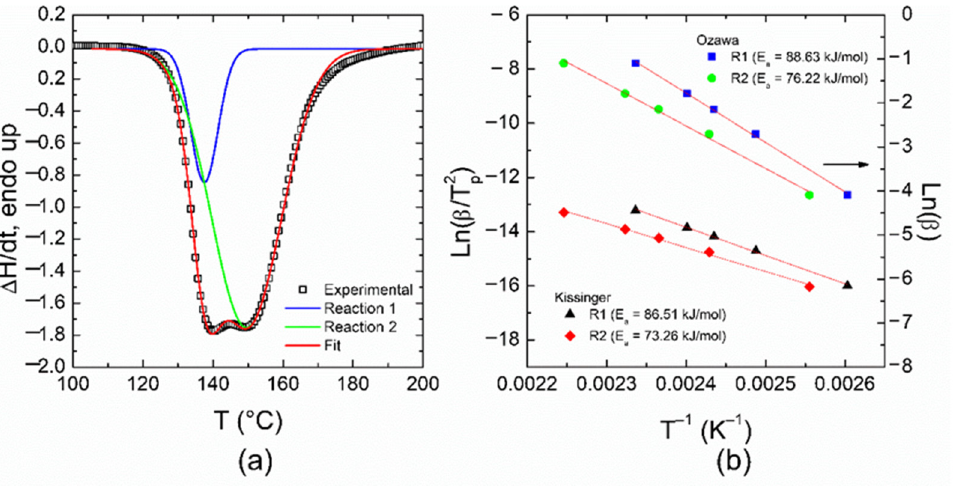
Figure 3. ( a ) Deconvolution of the DSC thermogram at β = 7 °C/min (after baseline correction) by using two Gaussian functions; ( b ) Ozawa and Kissinger plots for the determination of kinetic parameters. Fitting curves are shown as red lines.